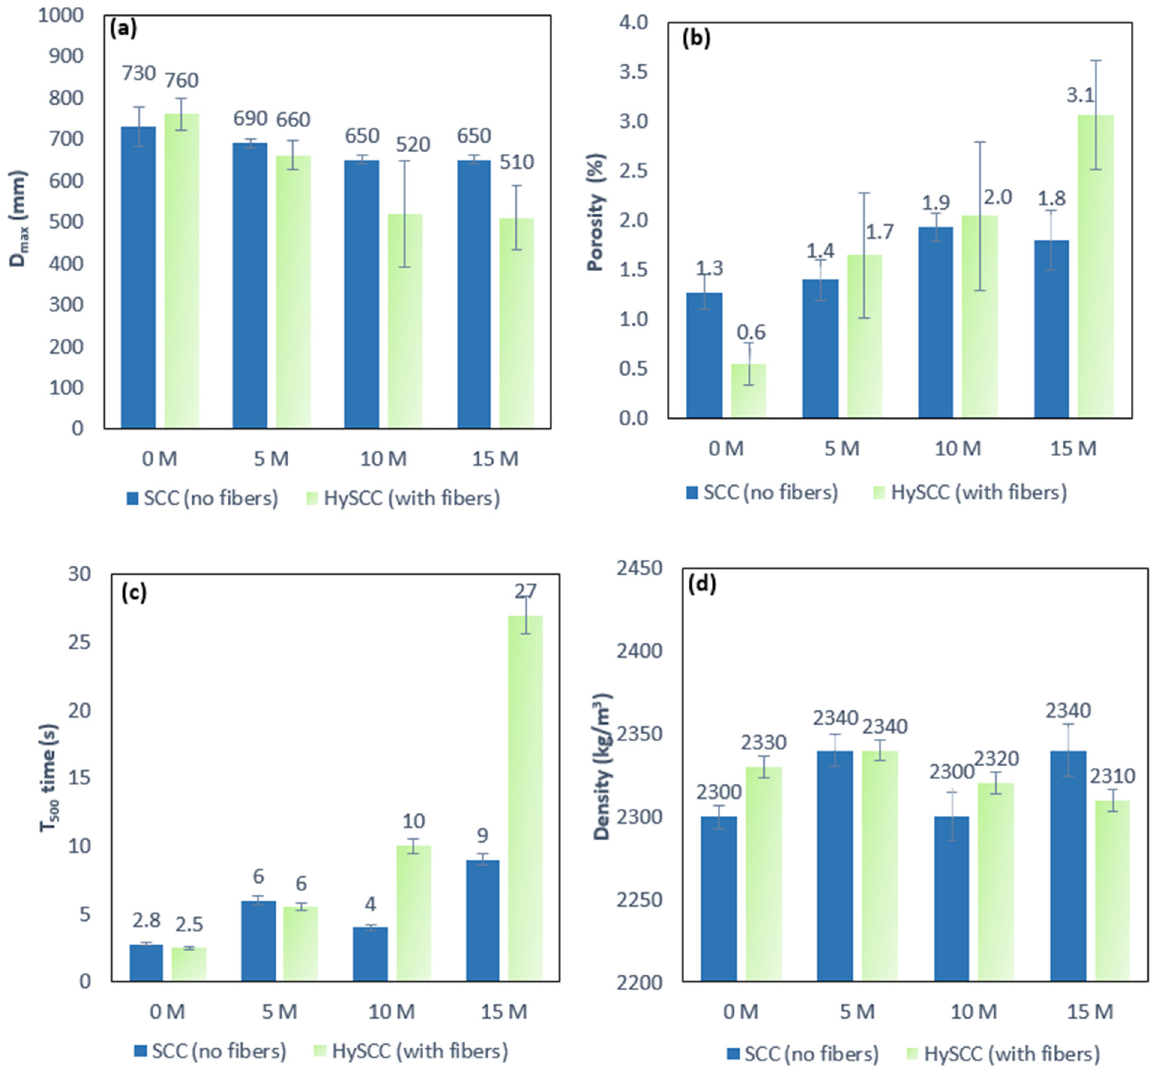
Figure 1. Effects of metakaolin and hybrid fibers on the workability of fresh SCC mixes on ( a ) flow diameter, ( b ) porosity, ( c ) time of flowing, and ( d ) density.